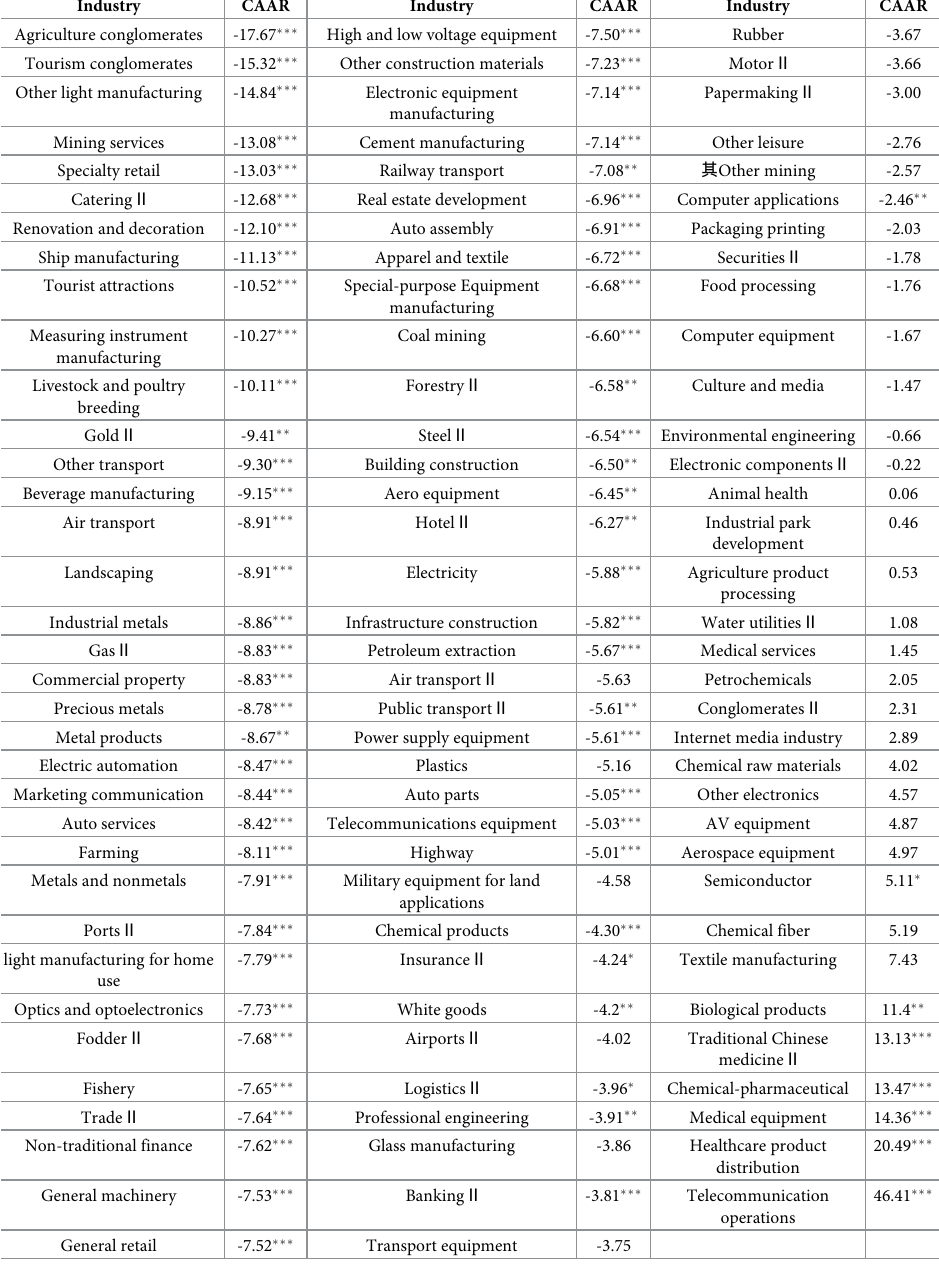
Table 4. Industry-specific impact at 2-digit level under CSRC scheme, 9-day event